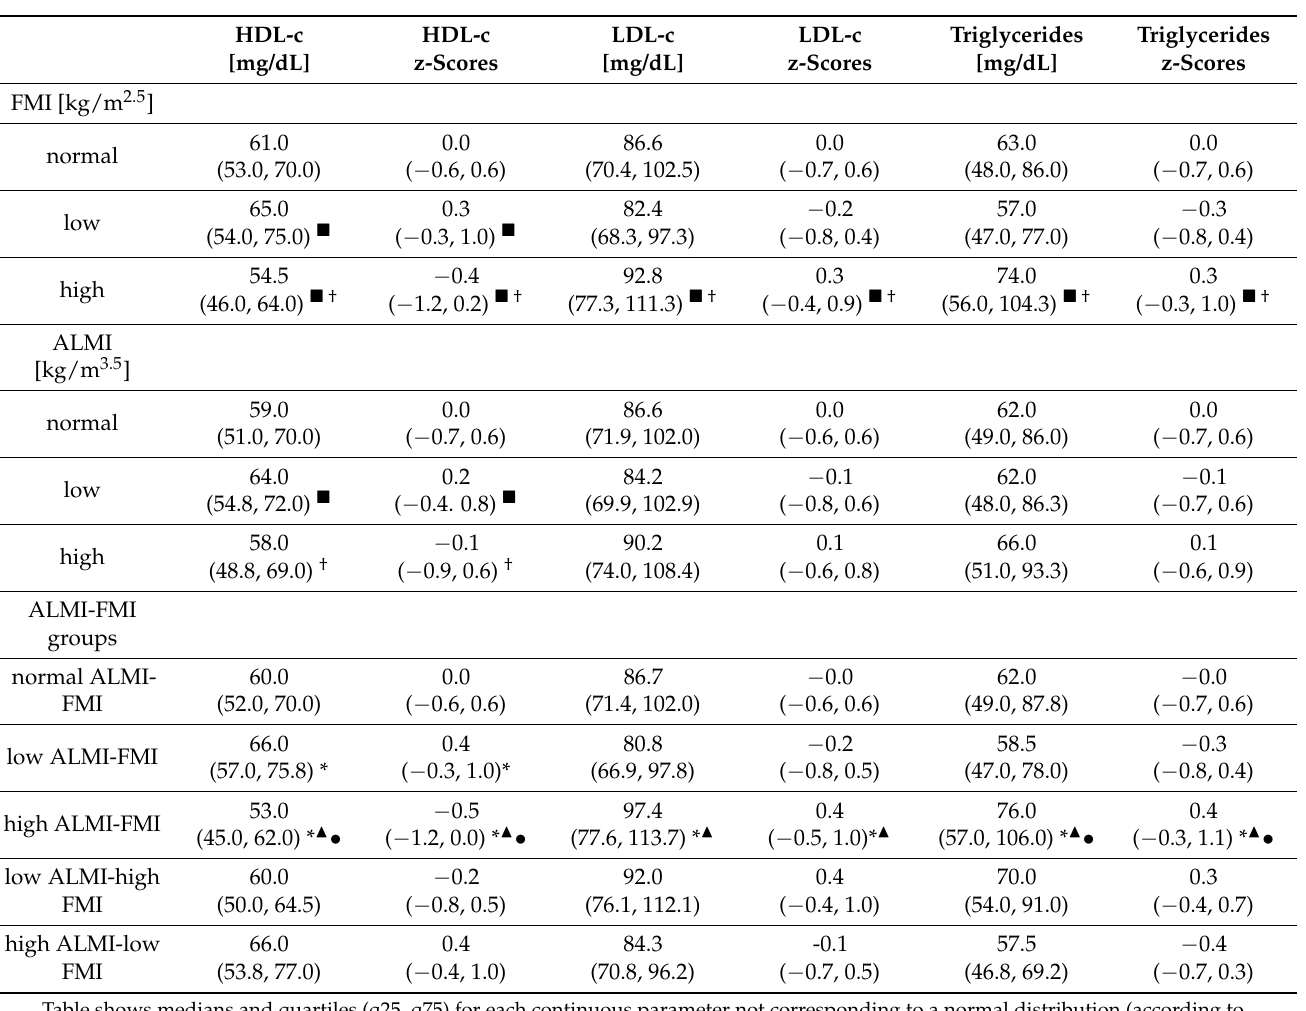
Table 2. Characteristics of serum lipid profiles in body composition